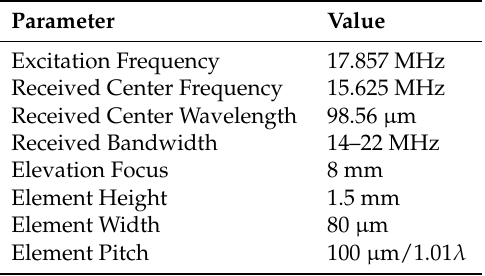
Table 1. The relevant transducer specifications and system settings are given